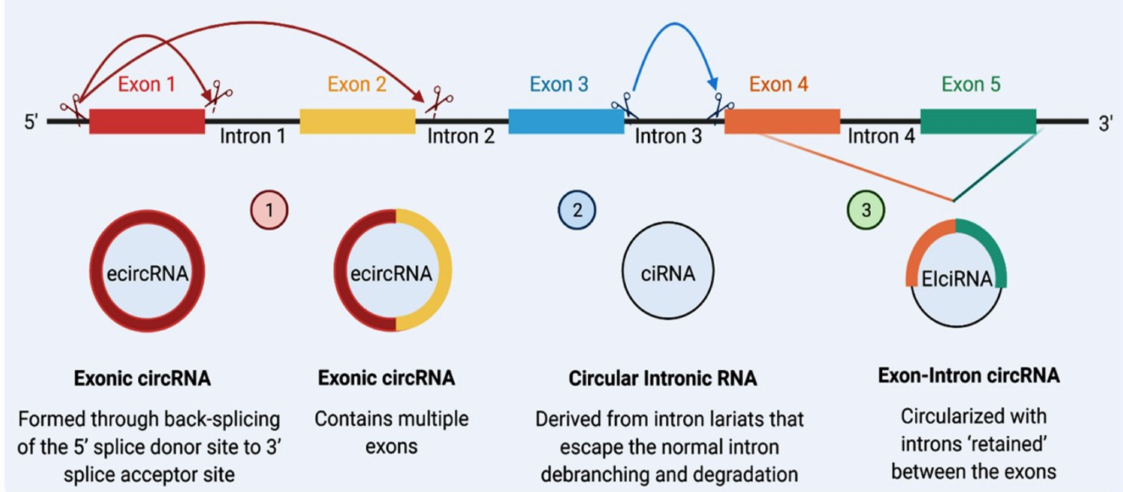
Figure 1. The biogenesis of circRNAs. There are three major classes of circRNAs: Class (1) Exonic circular RNA (ecircRNA): Initially, intron No. 1 is removed, and the 5 (cid:48) splice site of exon No. 2 is brought close to 3 (cid:48) splice site of Exon No. 1, creating ecircRNA that contains multiple exons. Exons can also skip splicing; exon No. 1 can also link with exon No. 3. Class (2) Circular intronic RNA (ciRNA): Reverse complementary sequences of lariat intron spliced from pre-mRNA can pair to produce a closed-loop structure termed ciRNA. Class (3) Exon–intron circRNAs (EIciRNAs): Intron No. 4 can be retained with Exon No. 4 and Exon No. 5 to form an EIciRNA (Created by